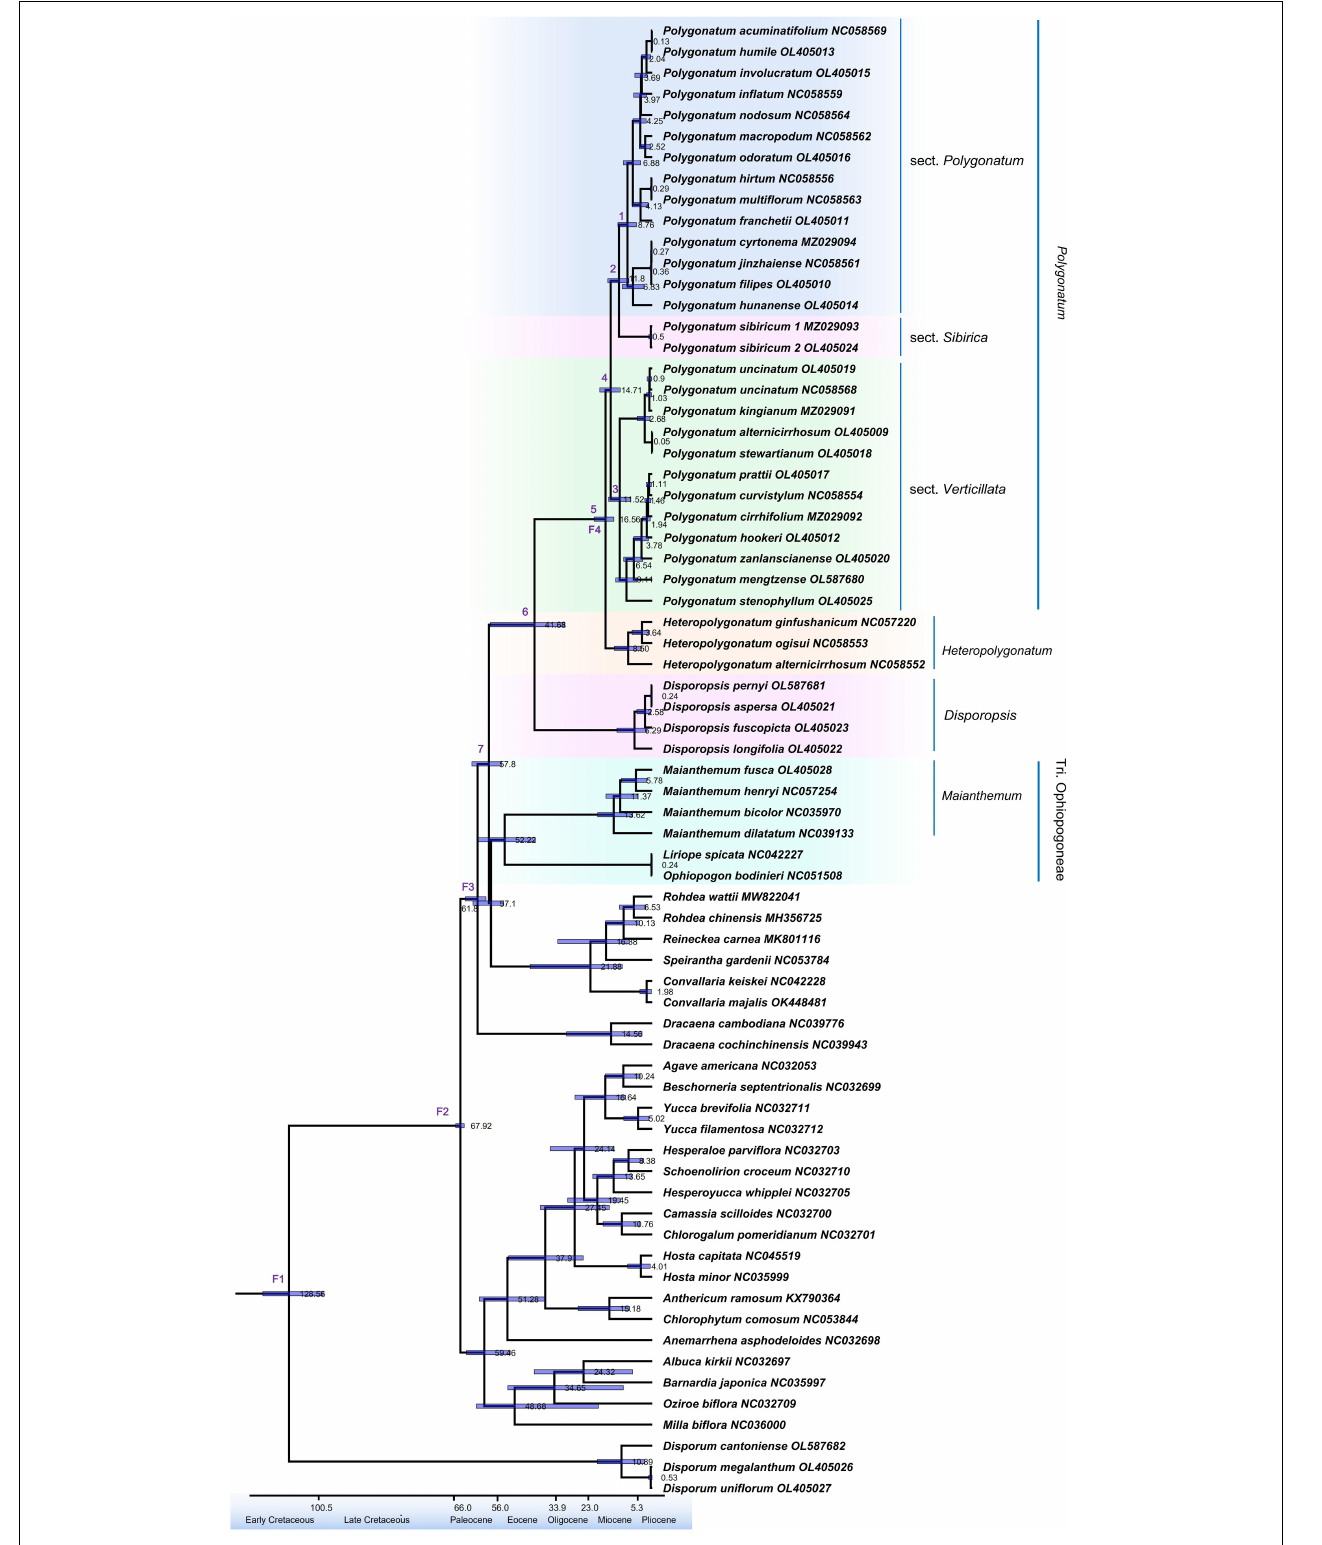
FIGURE 5 | Divergence time estimation based on cp genome sequences. The divergence times are exhibited on each node, whereas the blue bars represent the 95% highest posterior density interval for each node age.